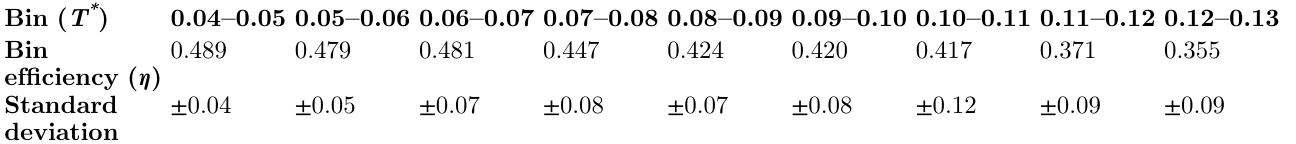
Table 1. Bin ef fi ciency and corresponding standard deviation referring to Figure 3(b). Bin ( T * )